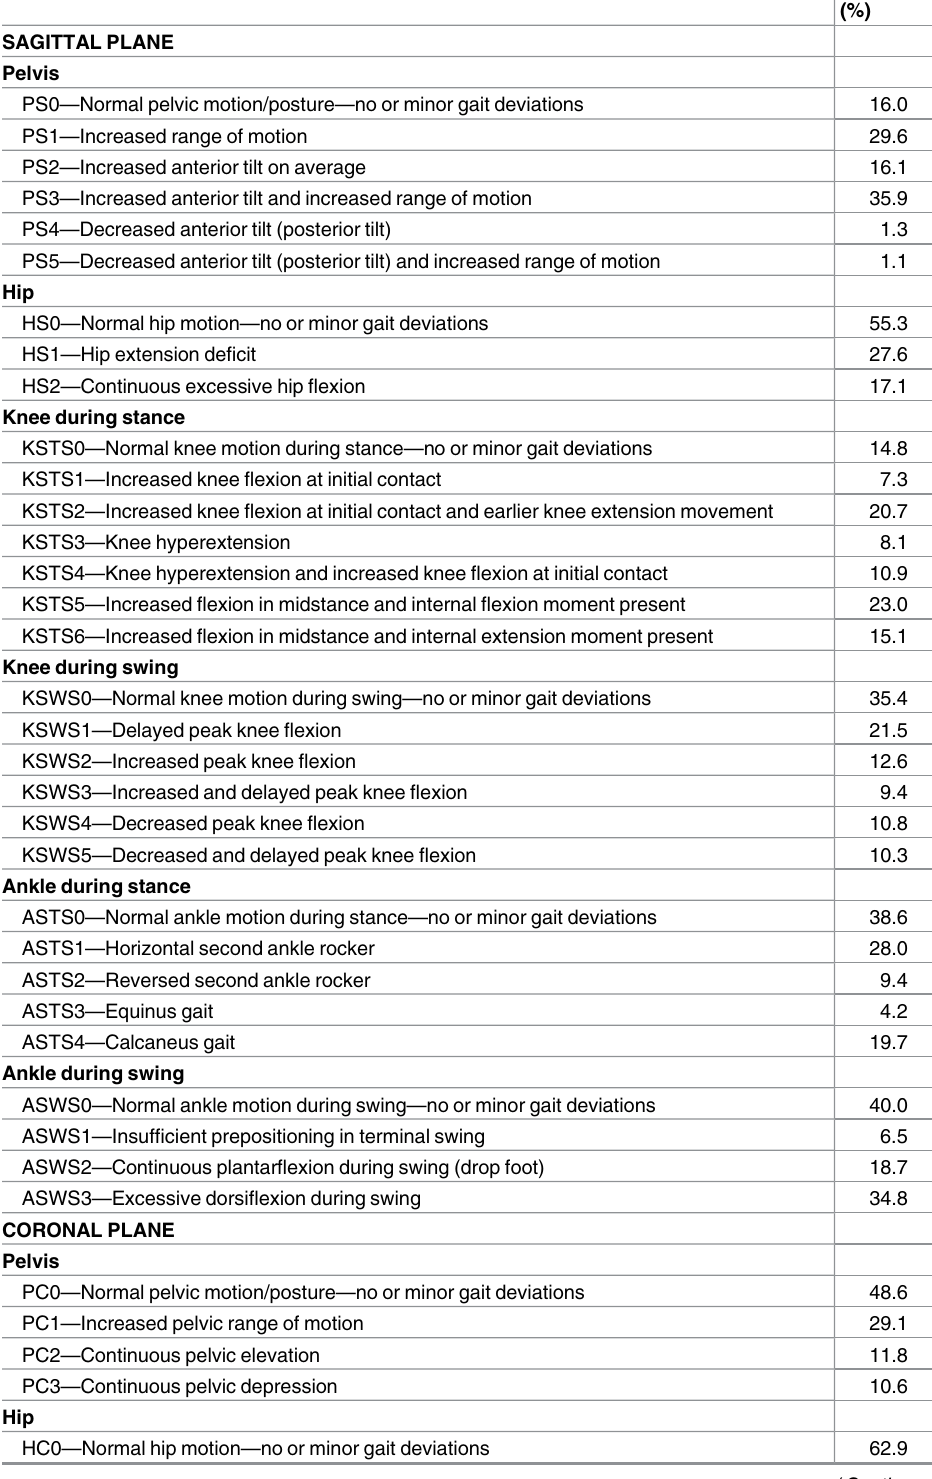
Table 1. Observed frequency (in %, N = 1719 trials) and brief description of all sagittal, coronal, and transverseplane joint motion patterns defined during the consensus